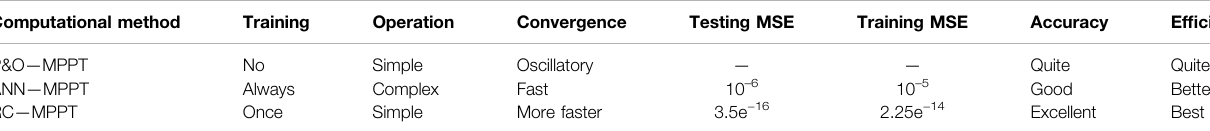
TABLE 2 | Summary of computational performance.